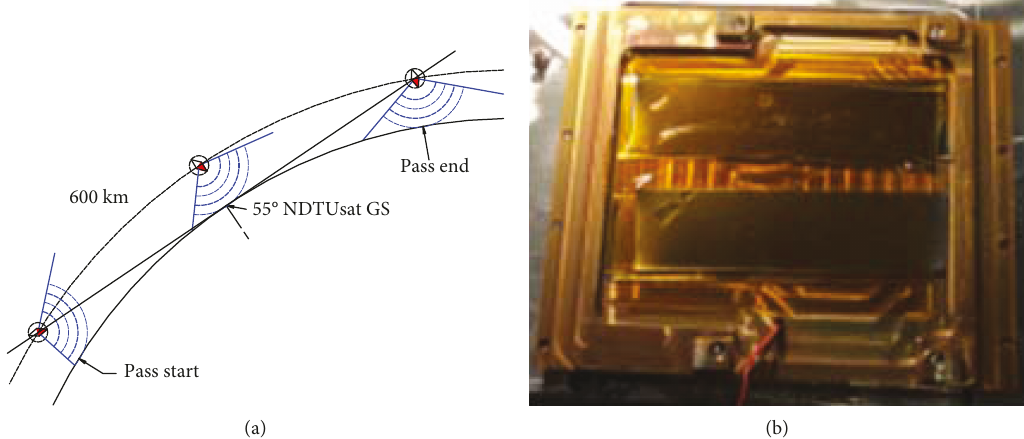
Figure 4: Illustration of how the descoped passive ACS system orients the satellite. The blue lines indicate the 3dB opening angle of the COM system antenna. (b) Image shows the μ -metal libration dampers mounted on one of the satellite panels.